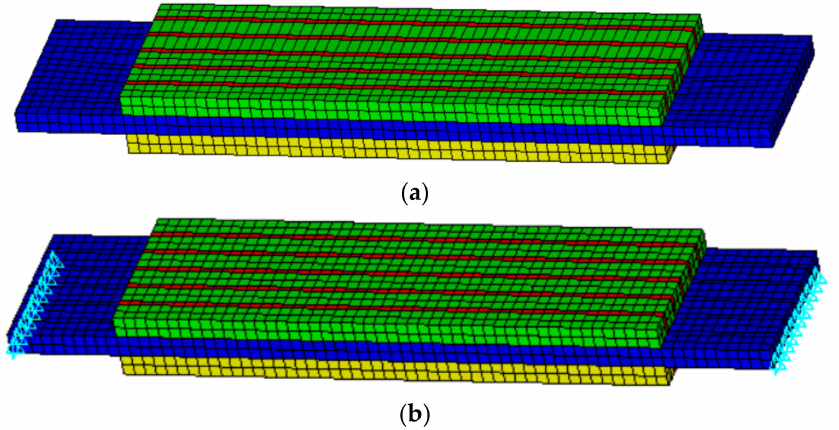
Figure 4. Finite element model with meshing: ( a ) free boundary; ( b ) fixed boundary. Quantities of 0 and +1 V alternating voltage are applied to the upper and lower surfaces of the established finite element model, and the Harmonic option in ANSYS (15.0, ANSYS, Inc., Pittsburgh, PA, USA) is selected as the analysis type. The frequency range is set as 1–9 kHz, the scanning substep is set as 200 and the damping coefficient is set as 0.02; then, calculation is performed. After the calculation, the admittance frequency curve is read with an ANSYS post-processor and the vibration mode at the resonance frequency point is observed. The vibration mode of the trilaminar vibrator is shown in Figure 5, which is the bending vibration in the transverse direction.